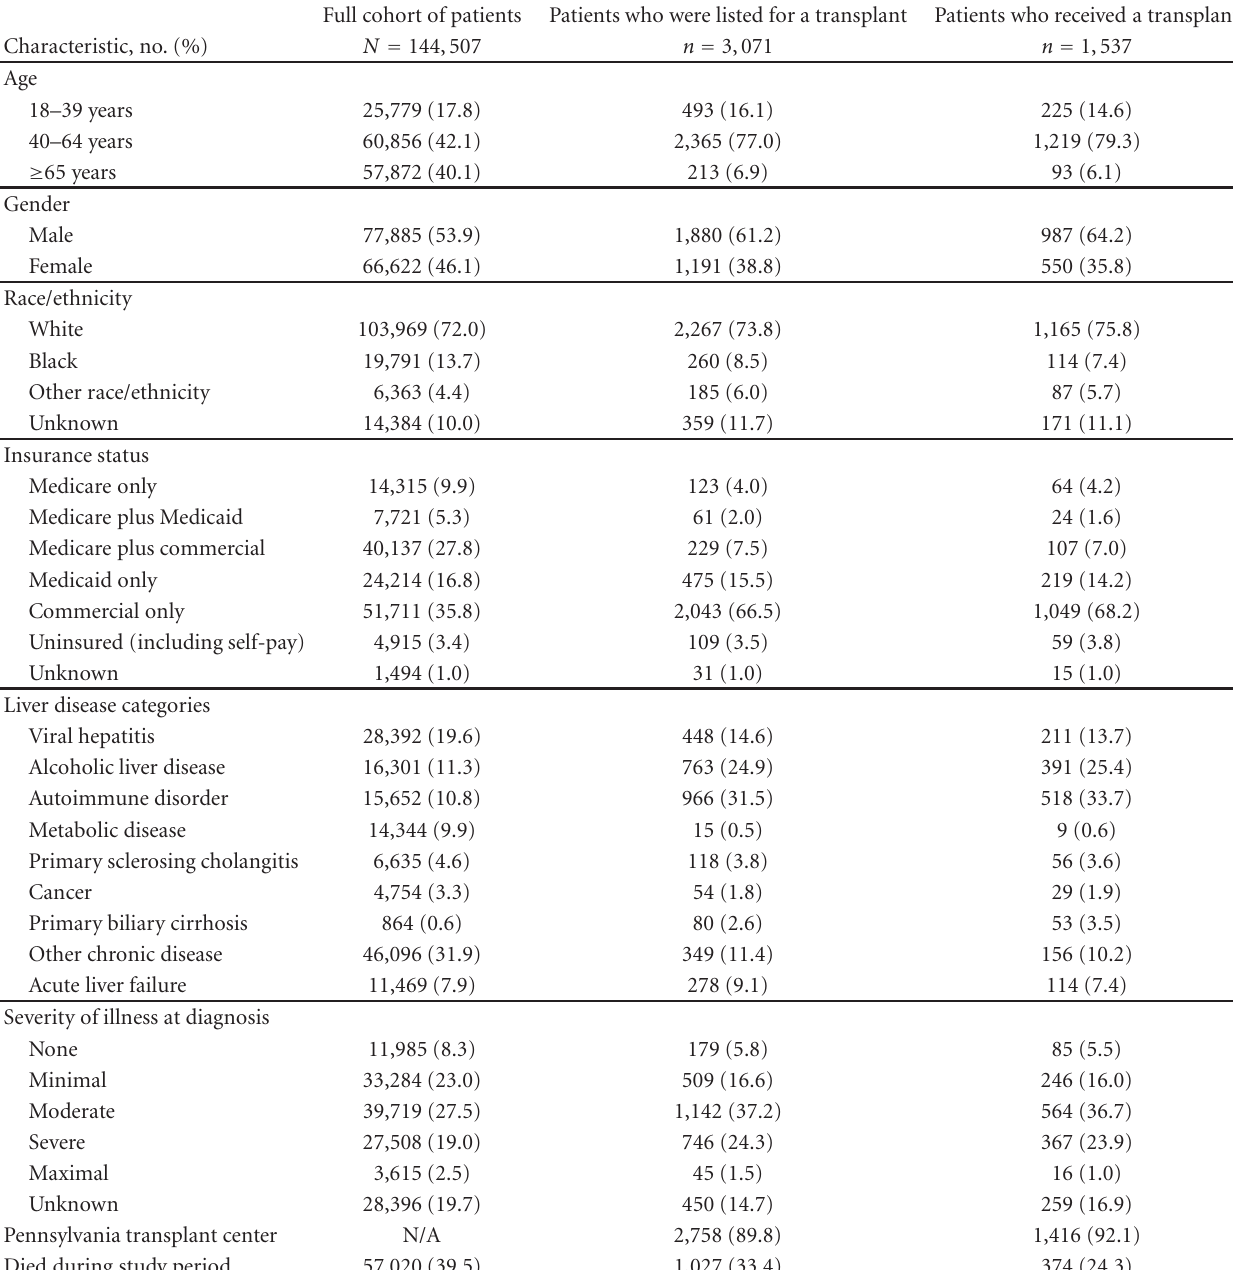
Table 1: Characteristics of patients with liver-transplant potential ∗